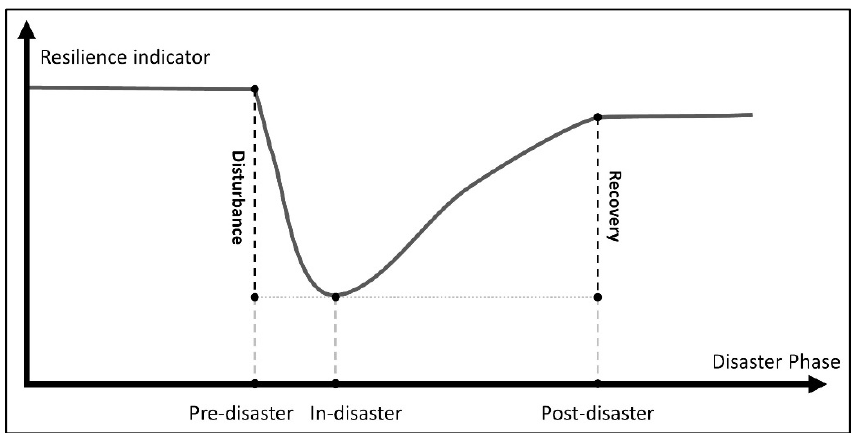
Figure 3. The conceptual framework of recovery trajectories and sampling time points used in this study.